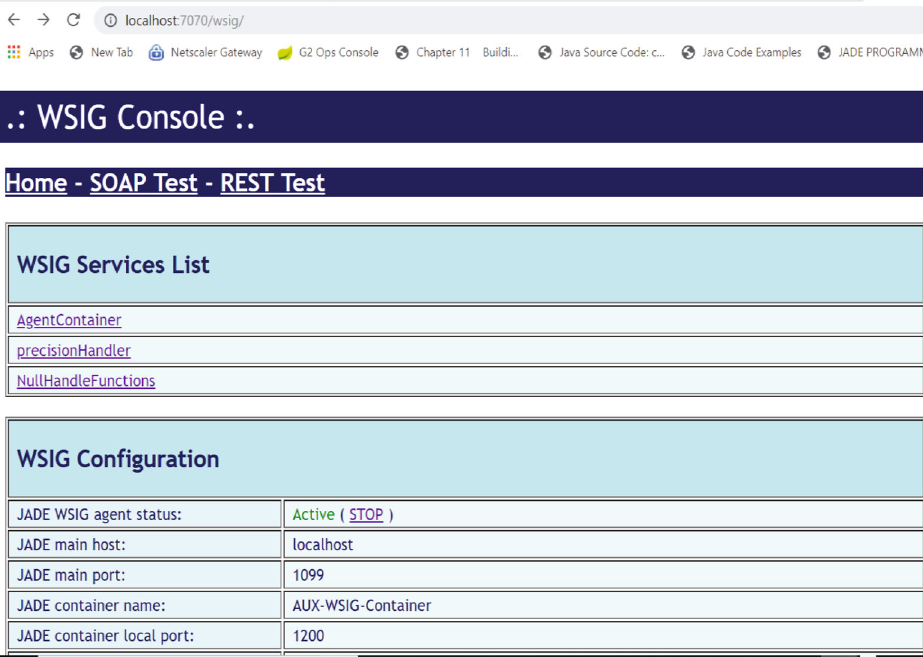
Figure 14: WSIG-agent service list.